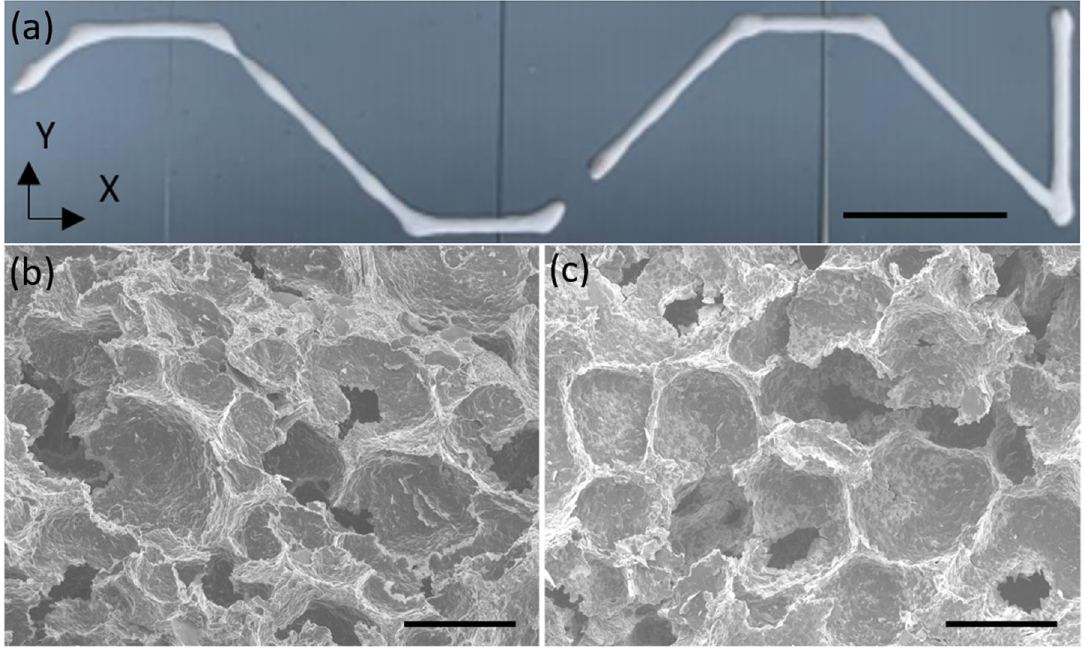
Fig. 1 Optical and SEM images of the printed foam. a Optical image of the foam immediately after printing on glass slides in microgravity. b , c Cross-sectional SEM images of the air-dried foams printed in ( b ) microgravity and ( c ) Earth gravity. Scale bars are a 25 mm and b , c 100 μ